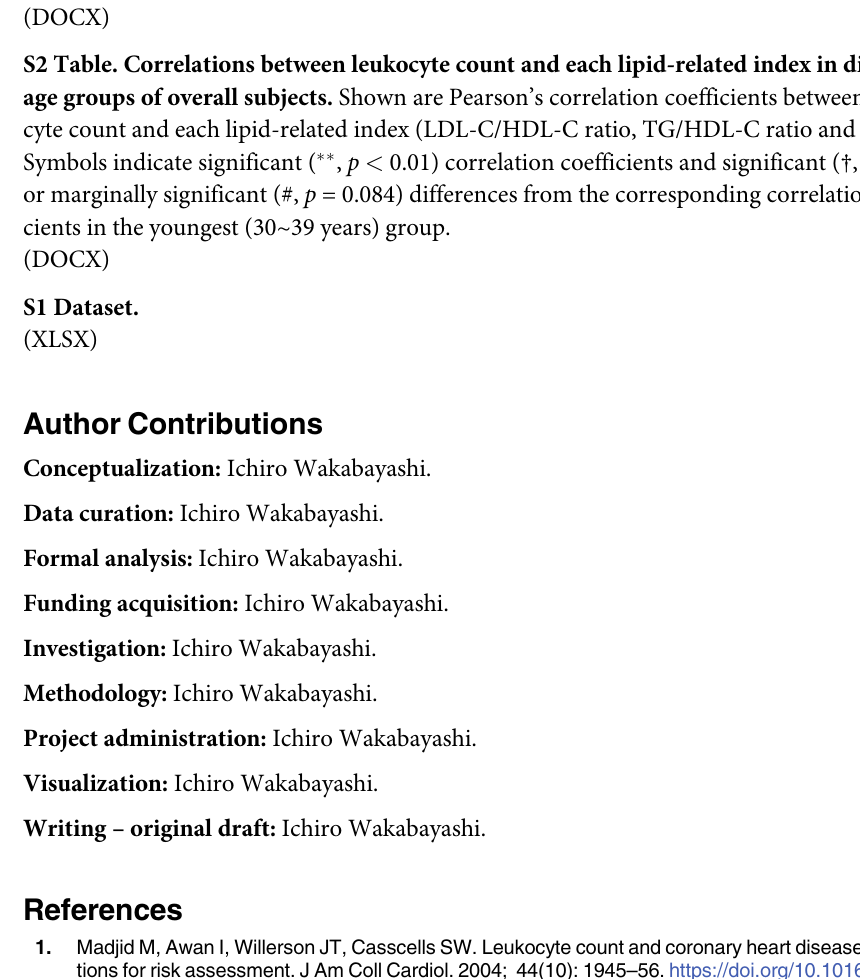
S1 Table. Correlations between each pair of leukocyte count and cardiometabolic risk fac- tors in overall subjects. Shown are Spearman’s rank correlation coefficients between each pair of leukocyte count and cardiometabolic risk factors in overall subjects. WHtR, waist-to-height ratio; MAP, mean arterial pressure. Asterisks denote significant correlations ( �� , p < 0.01). S2 Table. Correlations between leukocyte count and each lipid-related index in different age groups of overall subjects. Shown are Pearson’s correlation coefficients between leuko- cyte count and each lipid-related index (LDL-C/HDL-C ratio, TG/HDL-C ratio and CMI). Symbols indicate significant ( �� , p < 0.01) correlation coefficients and significant (†, p < 0.05) or marginally significant (#, p = 0.084) differences from the corresponding correlation coeffi- cients in the youngest (30~39 years)